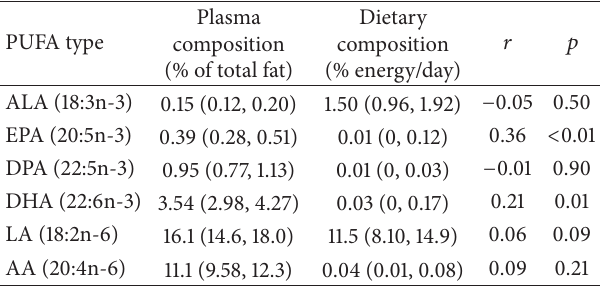
Table 2: Spearman correlation coefficients between plasma and dietary polyunsaturated fatty